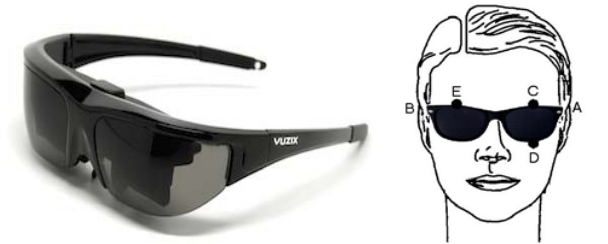
Figure 2. EOG goggles based on Vuzix Wrap 230